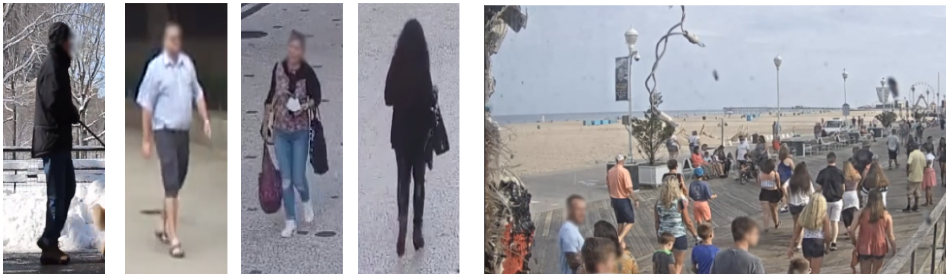
Figure 3. Samples of people walking from UWG. As opposed to strictly controlled mainstream datasets, the skeleton sequences provided by UWG were captured in real-world conditions (including sequences from crowded scenes) and with real-world confounding factors (in the form of heavy clothing, a variety of footwear, and multiple carrying conditions). Faces are blurred for privacy reasons. UWG contains only anonymized, out-of-context skeleton sequences—samples shown here are only for illustrating the real-world confounding factors.